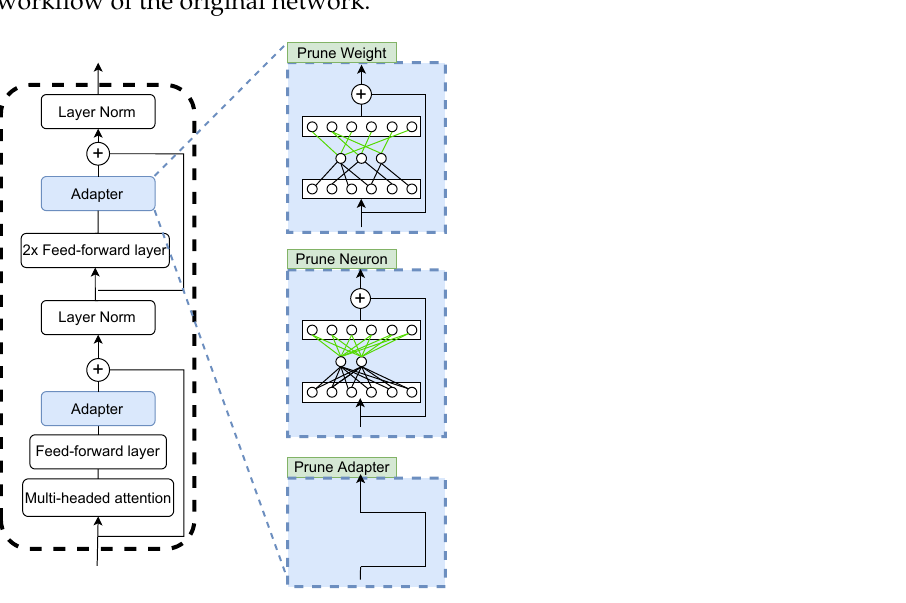
Figure 1. Three different ways of pruning the adapter module, which is a residual network with one